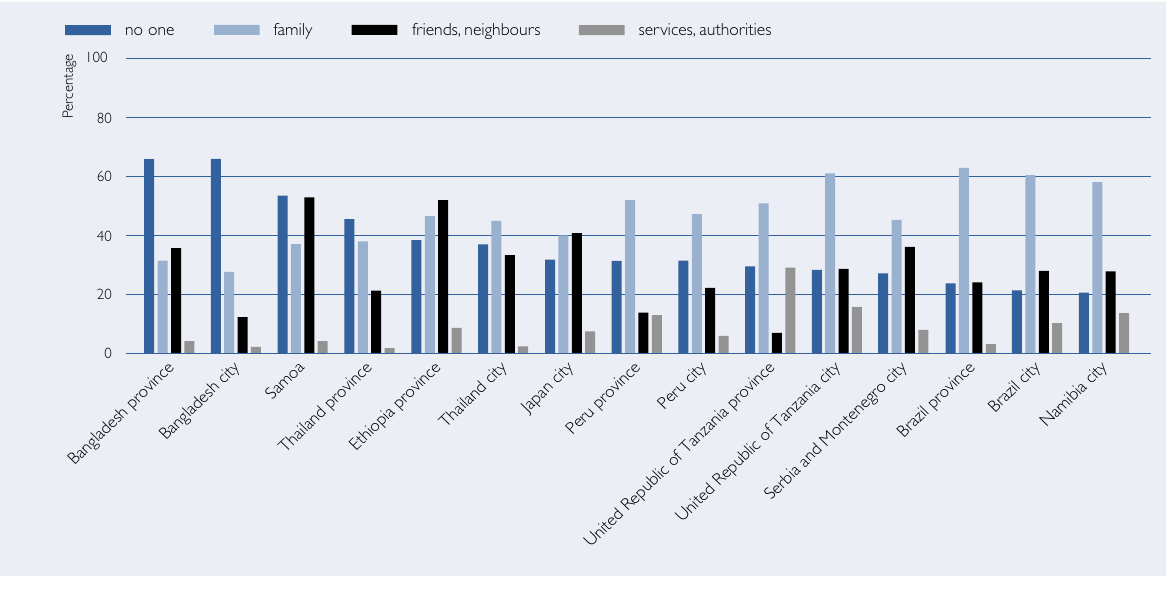
Figure 13 Percentage of ever physically abused women who had told no one, someone, or a service or authority about their experience of intimate-partner violence, by site family friends, neighbours services, authorities